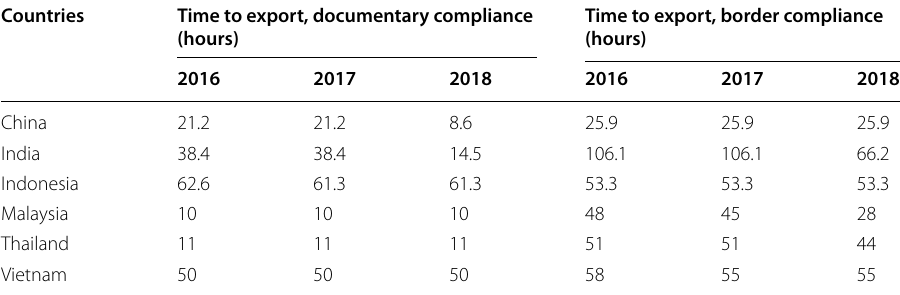
Table 9 Trade facilitation in time to export. Source: Doing Business Database, The World Bank Countries Time to export, documentary compliance (hours)